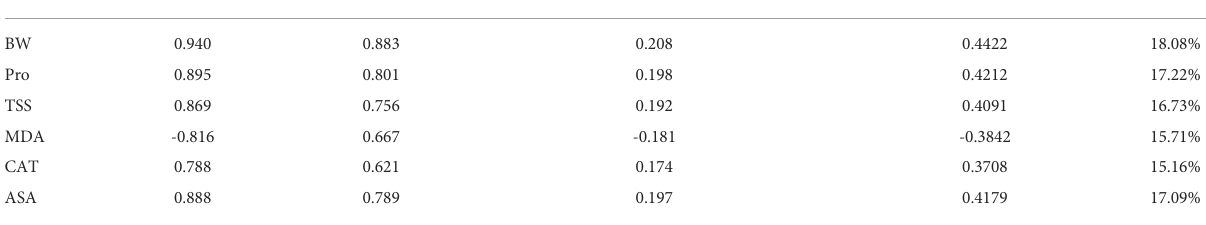
TABLE 6 Principal component analysis of cold resistance indexes.